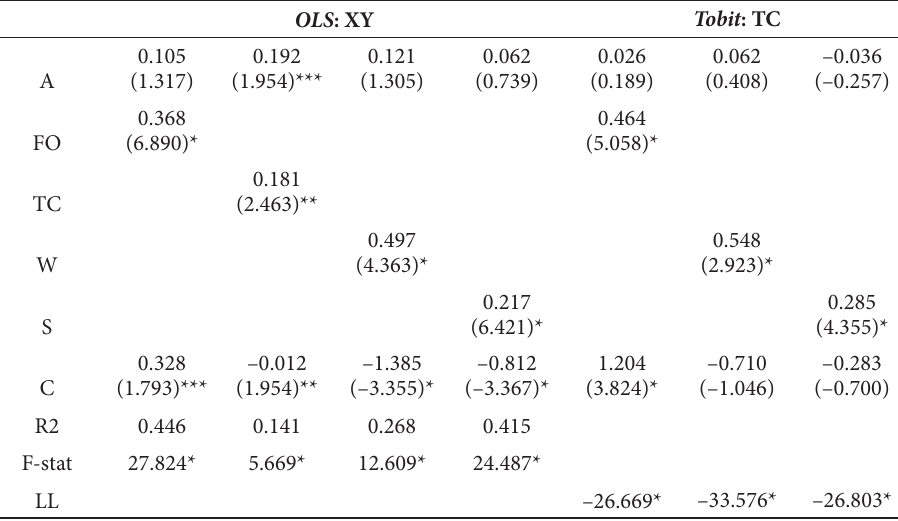
Table 5. Export intensity and technological capability regressions, Garment firms, Myanmar, 2010 OLS : XY Tobit :